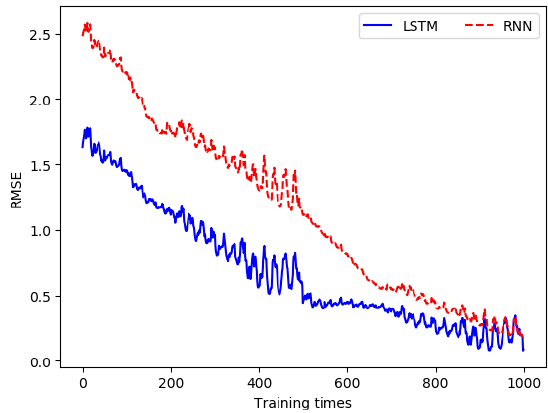
Figure 17. Comparison of RMSE for pH.